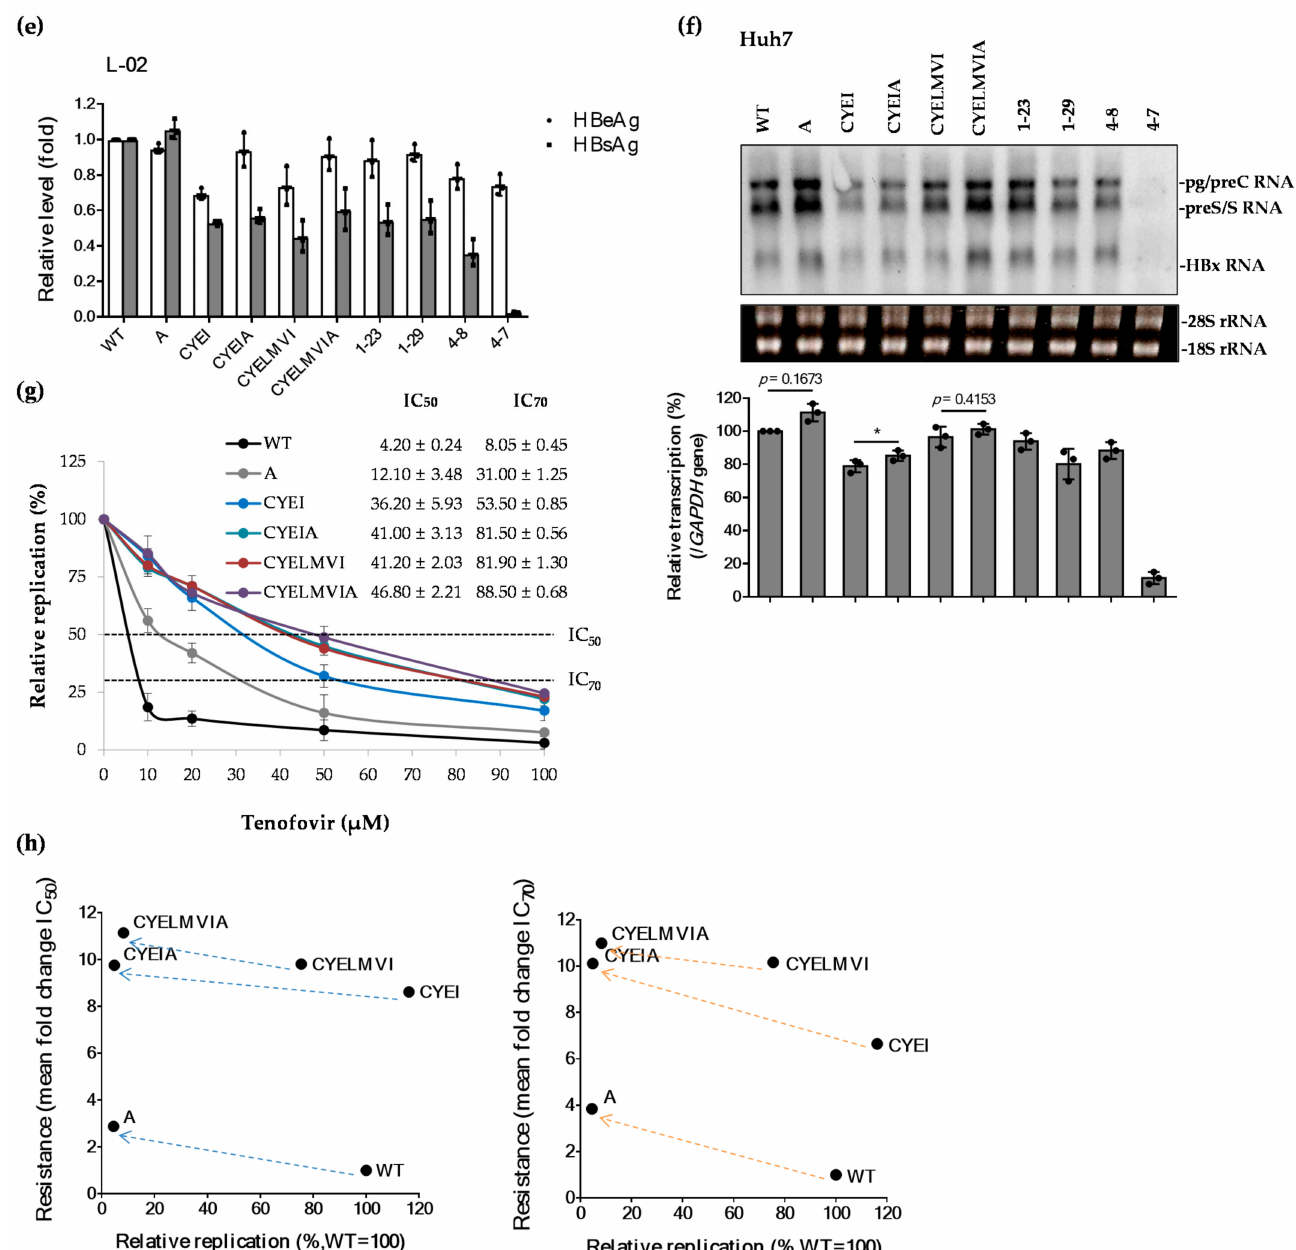
Figure 5. Effect of the rtT301A mutation on replication ability, viral transcription, and tenofovir resistance in different hepatoma cell lines. ( a ) A schematic representation of artificial mutant clones. The rtT301A mutation was introduced to each WT, CYEI, and CYELMVI clone a by site-directed mutagenesis. ( b , c ) The artificial and patient-derived HBV RT mutant clones were transfected into Huh7 ( b ) or HepG2 cells ( d ), and HBV replication was analyzed by Southern blot. The levels of secreted HBeAg and HBsAg were measured by ELISA. ( d ) The replication capacity was determined and compared in Huh7 and HepG2 cells by quantitative real-time PCR. The WT replication value was set to 100%. ** p < 0.01; *** p < 0.001. ( e ) The secreted HBeAg and HBsAg levels of each clone in L-02 cells. ( f ) HBV RNA levels of each clone was determined by Northern blot (upper) and quantified by quantitative real-time PCR (lower) in Huh7 cells. * p < 0.05. ( g ) Effect of the rtT301A mutation on susceptibility to tenofovir treatment. The IC 50 and IC 70 values of each clone were determined by quantitative real-time PCR in Huh7 cells. ( h ) Plots of IC 50 (left) or IC 70 (right) values vs. relative viral replication compared to the WT. Arrows indicate the decreased replication capacity and increased tenofovir resistance by rtT301A mutation. Data in ( b – h ) were obtained from three independent experiments (mean ± SD). pg/preC RNA, pregenomic/precore